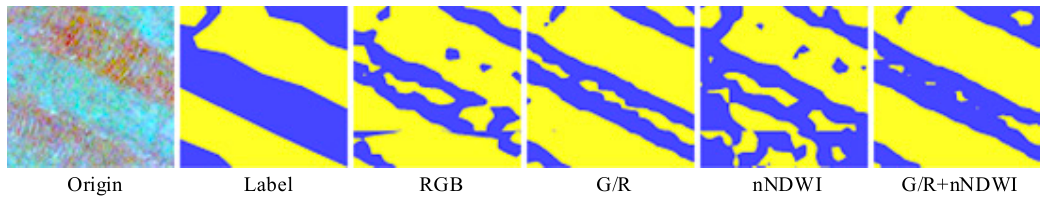
Figure 8. Comparison of noise interference in different groups.